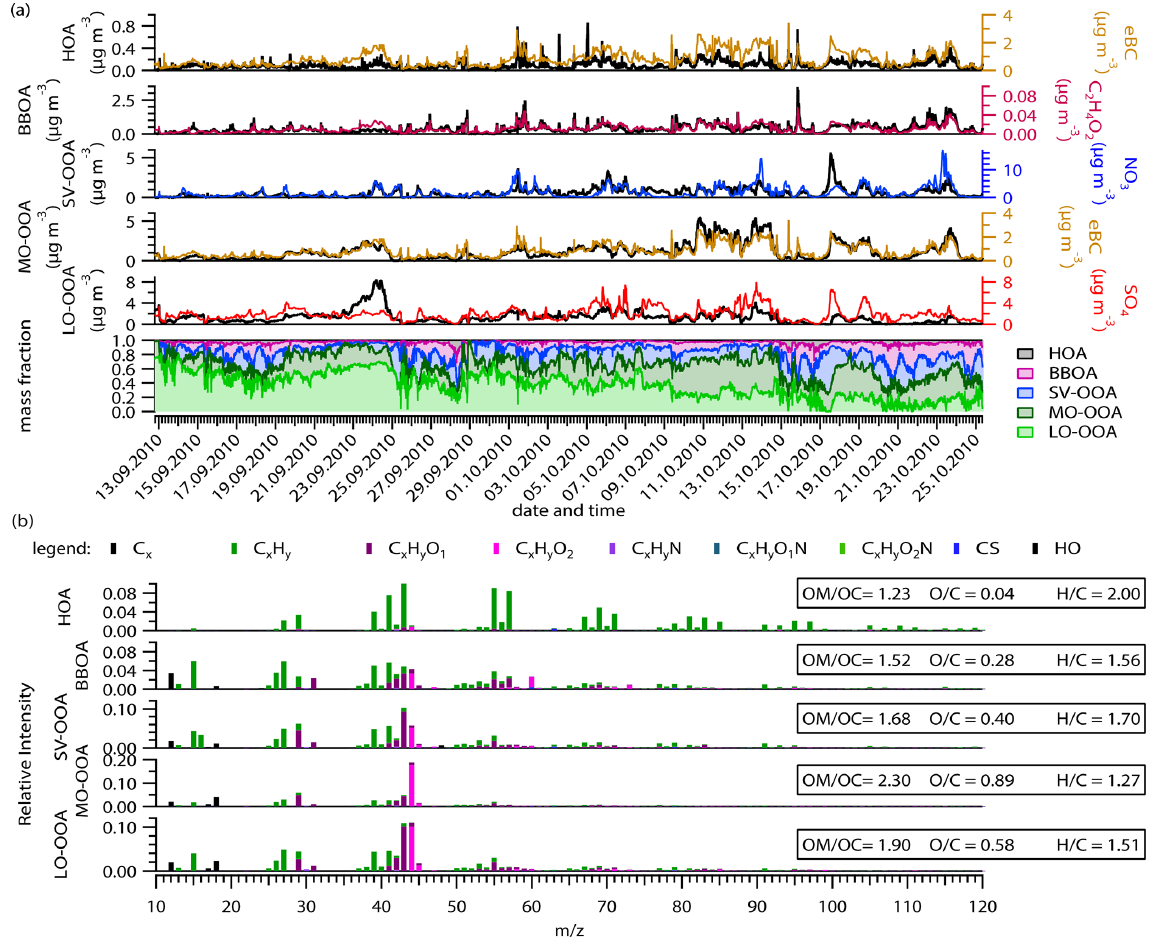
Figure 5. Overview of the ME-2 results. (a) Time series of the five-factor solution mass concentration and their corresponding tracers and the mass fraction of each factor throughout the experiment. (b) High-resolution mass spectra colored by the different groups of fragments and the elemental ratios of the identified